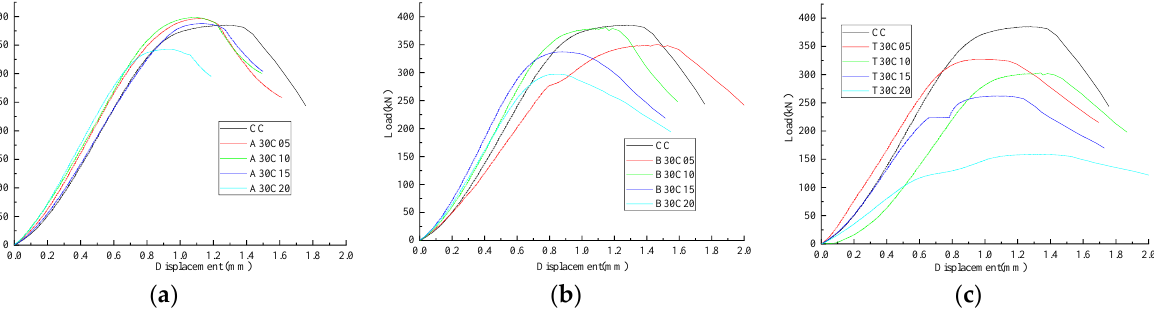
Figure 5. Load-displacement curves of all samples. ( a ) Alkalinized solution , ( b ) Boiling water , and ( c ) Tap water .